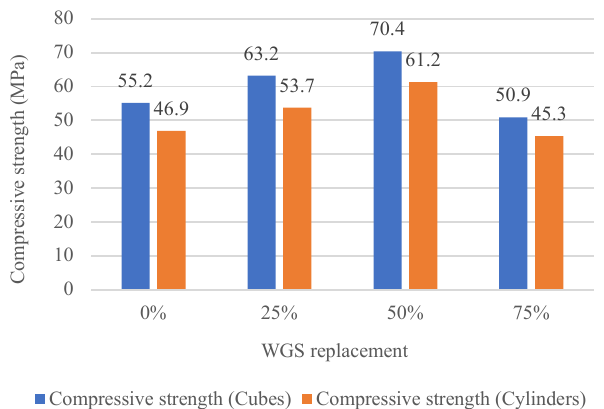
Figure 8. Compressive Strength Results at 28 days for cubic vs. cylindrical specimens.